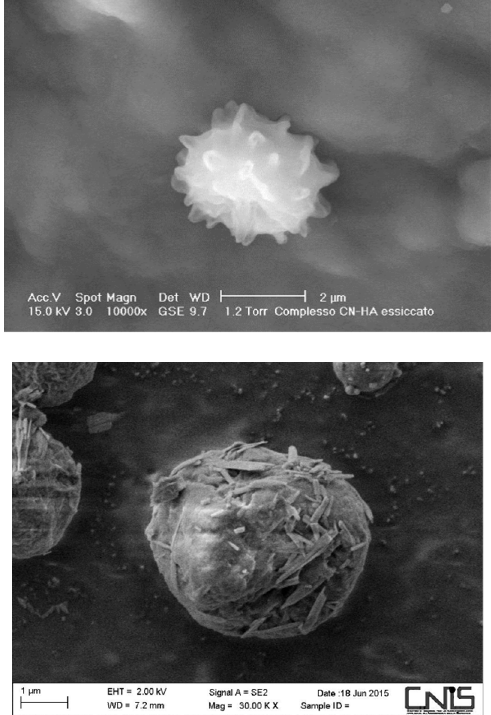
Figure 12. Nanoparticles of chitin nanofibrils–hyaluronan (on top ) and chitin nanofibrils–lignin ( below ).